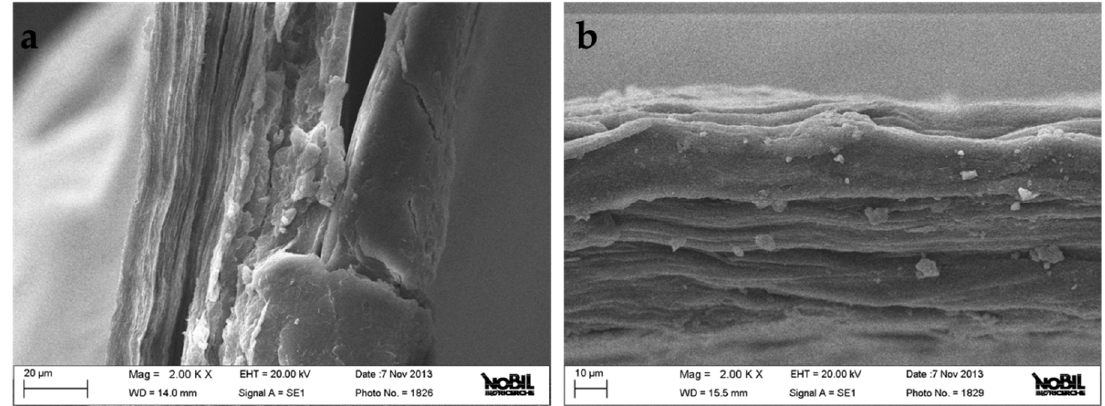
Figure 4. ( a ) SEM of pericardium control (P_CTRL). ( b ) SEM of pericardium treated with polyphenols (P_PRPE).